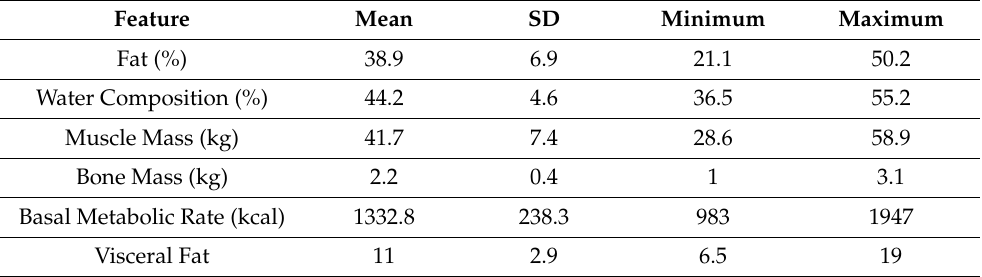
Table 3. Parameters of the distribution of body composition characteristics of the women examined.